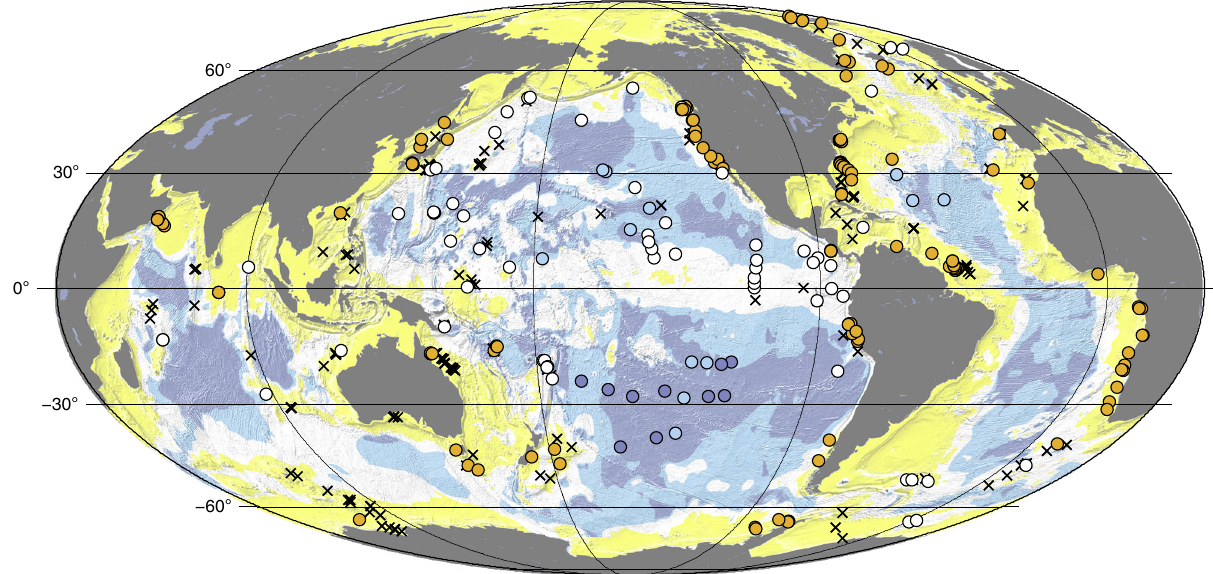
Fig. 1 Global distributions of dissolved O 2 and SO 4 2 − in subsea fl oor sediment. In yellow regions, dissolved SO 4 2 − is expected to disappear within the sediment and HCO 3 − is expected to be the predominant net electron acceptor at greater depths. In white regions, dissolved SO 4 2 − is expected to penetrate throughout the sediment, from sea fl oor to igneous basement. Dark blue and light blue regions respectively represent the minimum and maximum areas over which dissolved O 2 is expected to penetrate throughout the sediment from sea fl oor to basement 16 . SO 4 2 − reduction is expected to dominate net subsea fl oor organic oxidation in the yellow and white regions. O 2 reduction is expected to dominate net subsea fl oor organic oxidation in the blue regions. Orange dots mark drill sites where SO 4 2 − disappears within the fi rst 500 meters of sediment. White dots mark drill sites where SO 4 2 − penetrates the entire sediment sequence. Dark blue dots mark drill sites where dissolved O 2 and dissolved SO 4 2 − penetrate the entire sediment sequence. Medium blue dots mark coring sites where O 2 and SO 4 2 − penetrate to the bottom of the cores (meters to tens of meters) and may penetrate to basement. X symbols mark sites where the full extent of SO 4 2 − penetration is unknown, because SO 4 2 − is present in all measured samples, but the sedimentary sequence continues far below the last measurement. More information regarding the generation of this map is available in the Methods